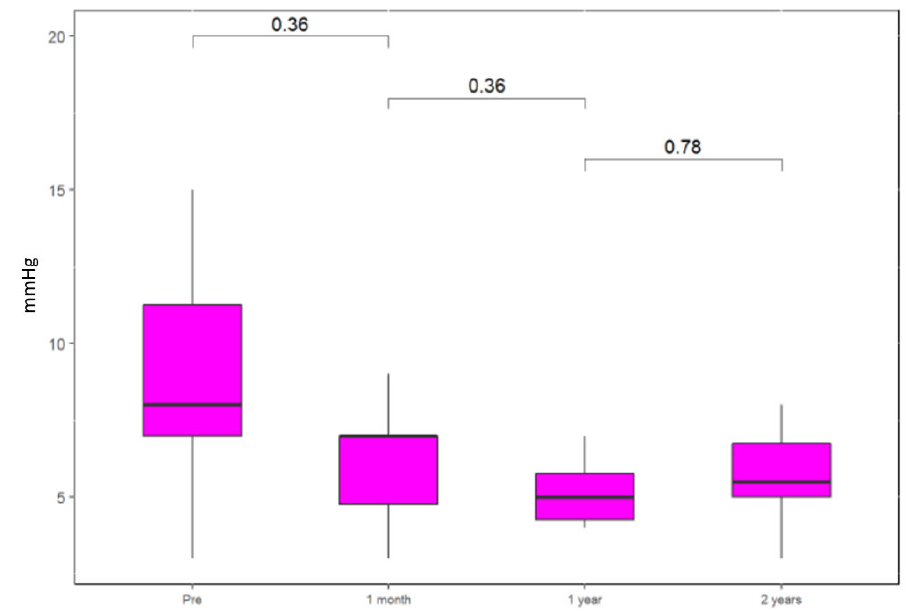
Figure 2. Mean gradients across tricuspid valve.